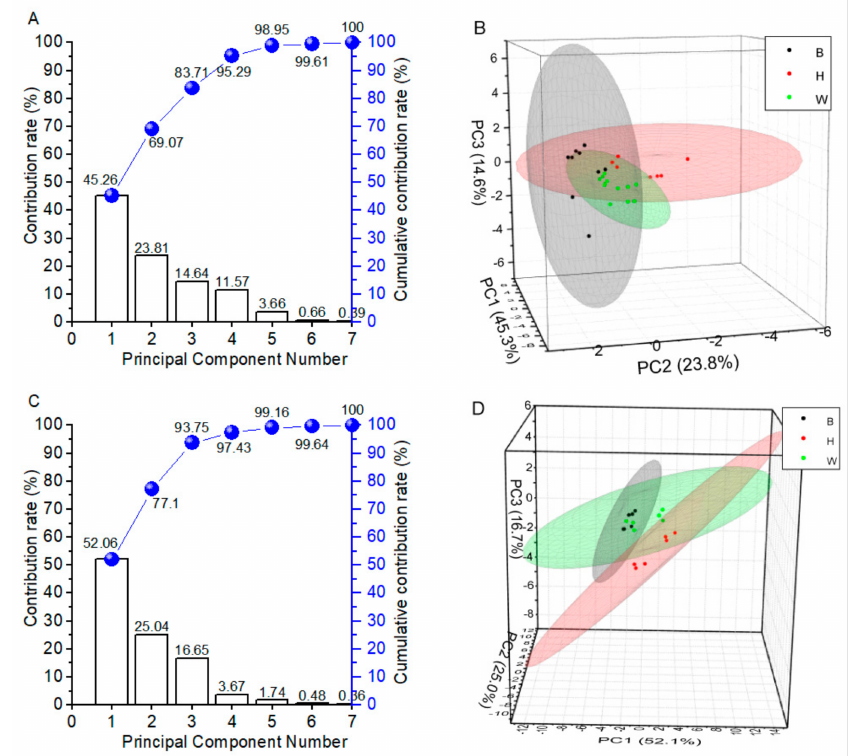
Figure 5. Principal component analysis (PCA) of egg yolks and albumen by electronic tongue ( n = 9). ( A ) Contribution rate and cumulative contribution rate of yolks. ( B ) PCA score plot of yolks. ( C ) Contribution rate and cumulative contribution rate of albumen. ( D ) PCA score plot of albumen. B, Beinong No.2; H, Hy-Line Brown; W,